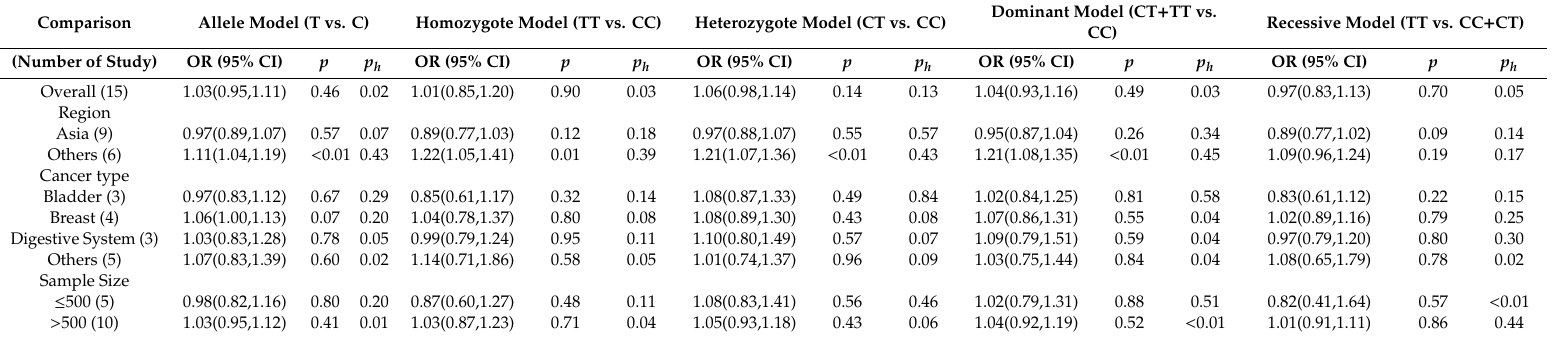
Table 3. Association between the MMP-8 rs11225395 polymorphism and cancer